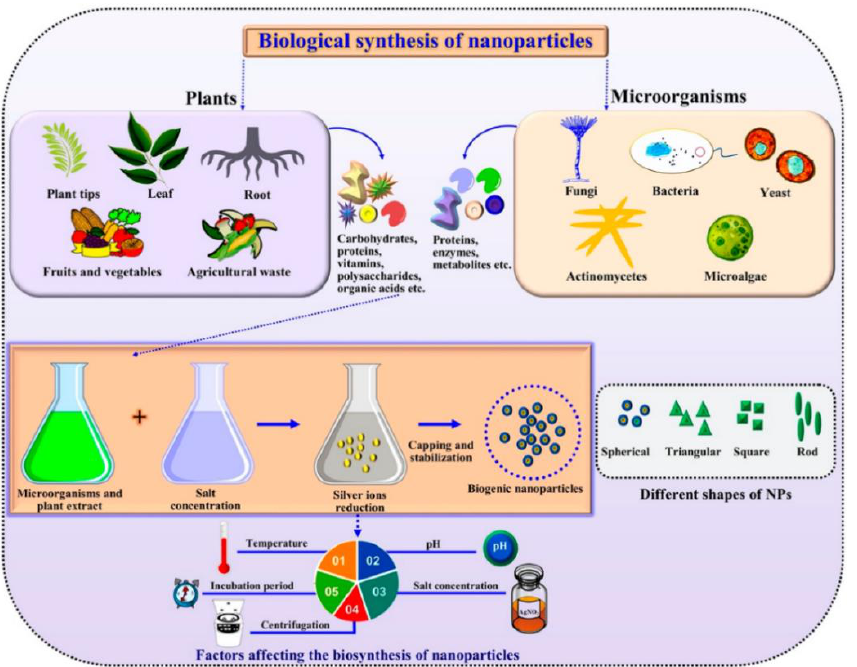
Figure 2. A generalized representation of the green synthesis of metallic nanoparticles [75].